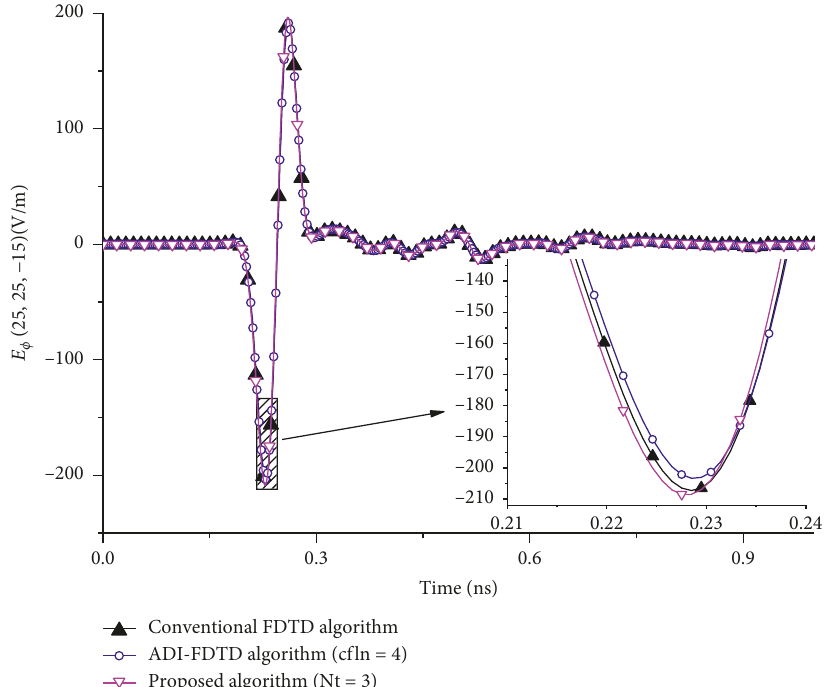
Figure 7: Computational results of E